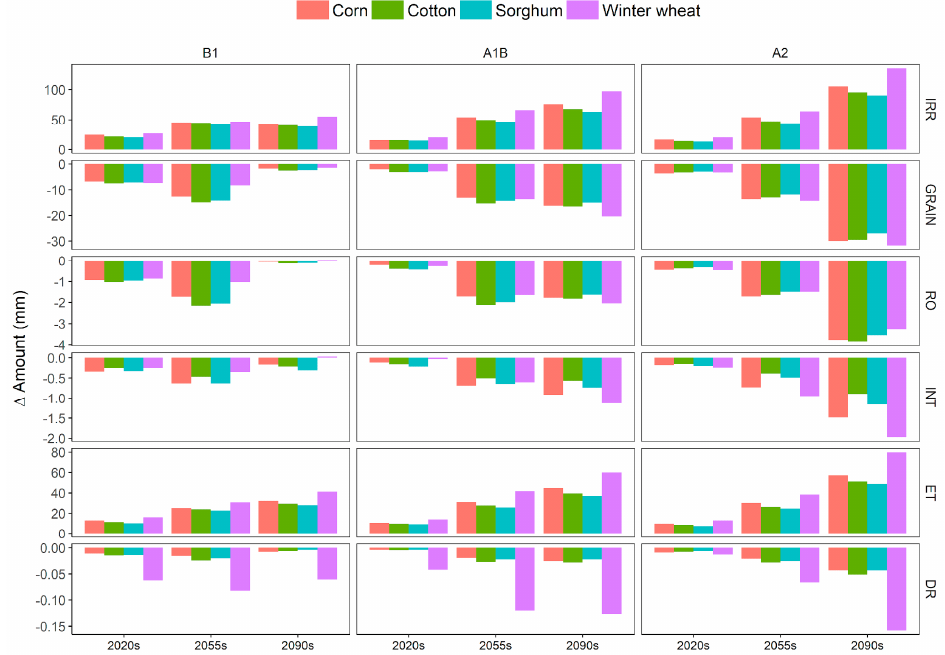
Figure 4. Projected changes in water budget components of different crops for three future periods under three greenhouse gas emissions scenarios. (Note: GRAIN—Gross Rainfall, IRR—Irrigation Requirement, ET—Crop Evapotranspiration, INT—Interception, RO—Runoff and DR—Drainage).